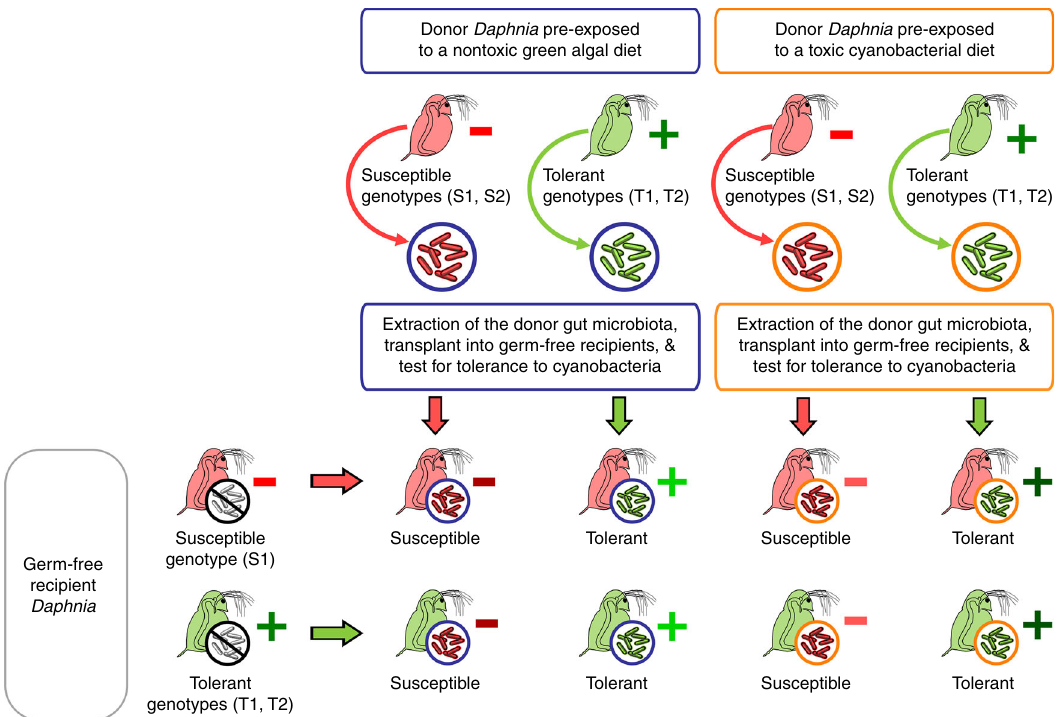
Fig. 2 Deciphering how genotype and gut microbiota interact to drive tolerance to toxic cyanobacteria through gut microbiota transplants in Daphnia . Donor Daphnia populations from either susceptible ( S1 and S2 ; red) or tolerant ( T1 and T2 ; green) genotypes were exposed to either a nontoxic green algal or a toxic cyanobacterial diet (blue and orange color, respectively) for 12 generations. Their gut microbiota was then extracted by crushing dissected guts, and inoculated into germ-free recipient Daphnia juveniles from susceptible ( S1 ; red) and tolerant ( T1 and T2 ; green) genotypes. Recipient Daphnia were subsequently fed on a cyanobacterial diet to determine their tolerance. We found that the level of tolerance to cyanobacteria in recipient Daphnia was co-determined by donor genotype and donor diet, and was not in fl uenced by recipient genotype. Symbols “ + ” and “ − ” indicate the performance (i.e., survival and reproduction) of recipient Daphnia upon cyanobacterial exposure, from the lowest performance (dark red “ − ” ) to the highest (dark green “ + ” ). Green and red colors indicate tolerance and susceptibility,